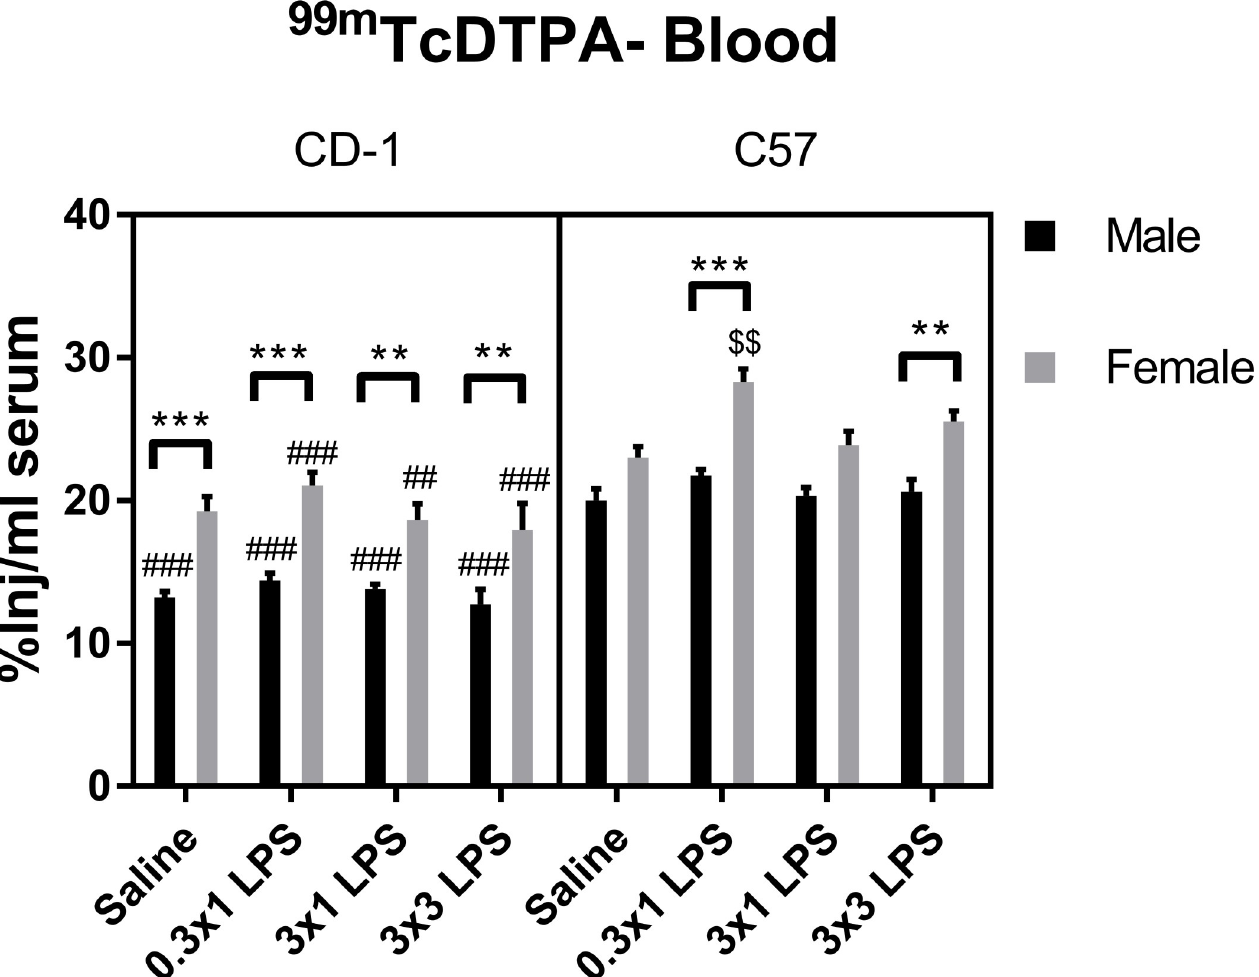
Fig 3. Effects of LPS on serum levels of 99m Tc-DTPA. Data are presented as means ± SEM, n = 8 per group. $ $p < 0.01 vs. saline treatment within the same sex and strain. ##p < 0.01, ###p < 0.001 vs. C57 within the same treatment group and sex. �� p, 0.01, ��� p < 0.001 vs. groups indicated, within the same strain and treatment.